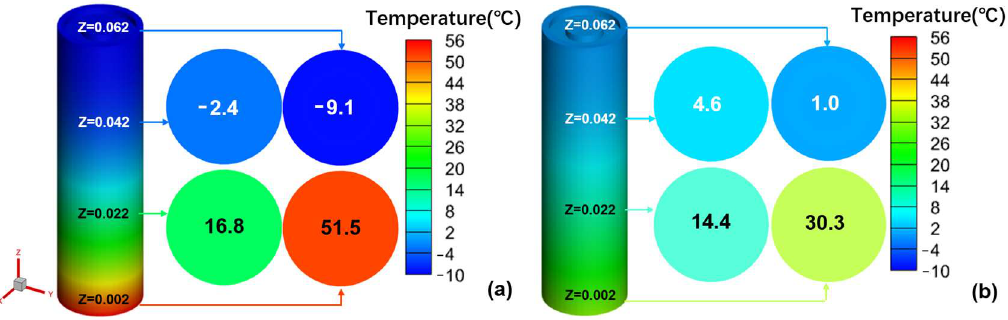
Figure 11. Cell axial temperature gradient distribution diagram. The cell axial thermal conductivity is ( a ) 35 W/(m·K); ( b ) 80 W/(m·K).